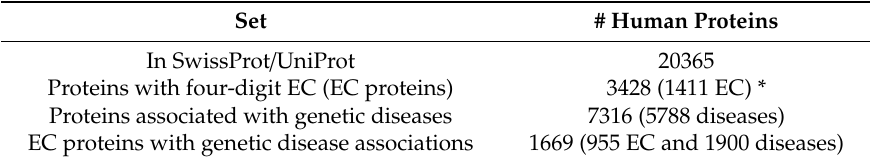
Table 1. Disease-related human proteins with enzyme commission (EC) number. Set